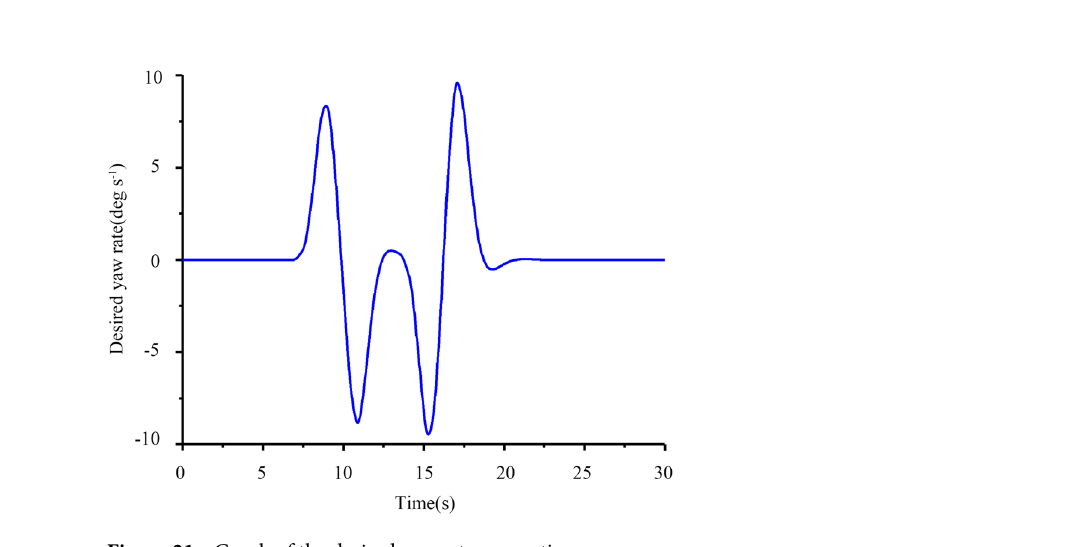
Figure 21. Graph of the desired yaw rate versus time.